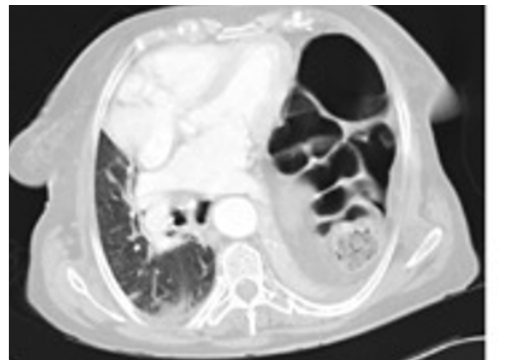
Figure 2. Thoracic CT scan. Left diaphragmatic relaxation, ascen- sion of the splenic angle of the colon, stomach and spleen up to the projection of left hilum, atelectasis of the right lower lobe by extrinsic compression, right postero-basal alveolar condensation process, heart displaced in the right